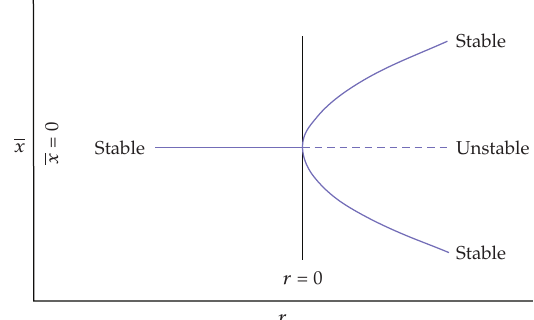
Figure 3: Phase diagram indicating the presence of a bifurcation for r (cid:8)